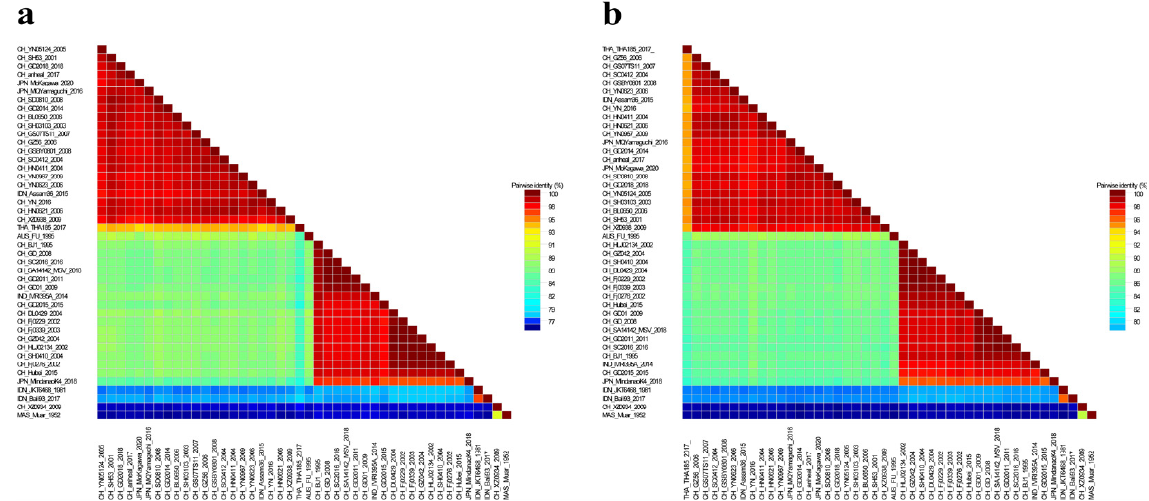
Figure 5. Nucleotide similarity of JEV isolates. ( a ) Nucleotide similarity of E gene of JEV isolates; ( b ) nucleotide similarity of JEV